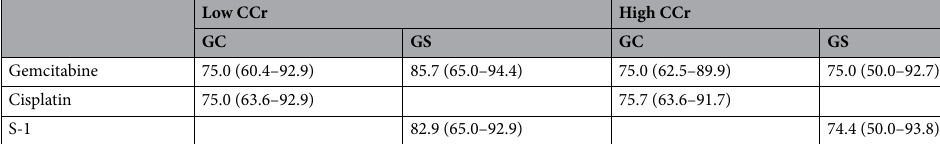
Table 3. Percentage of planned dose (median, IQR; %). CCr creatinine clearance, GC gemcitabine plus cisplatin, GS gemcitabine plus S-1, IQR interquartile